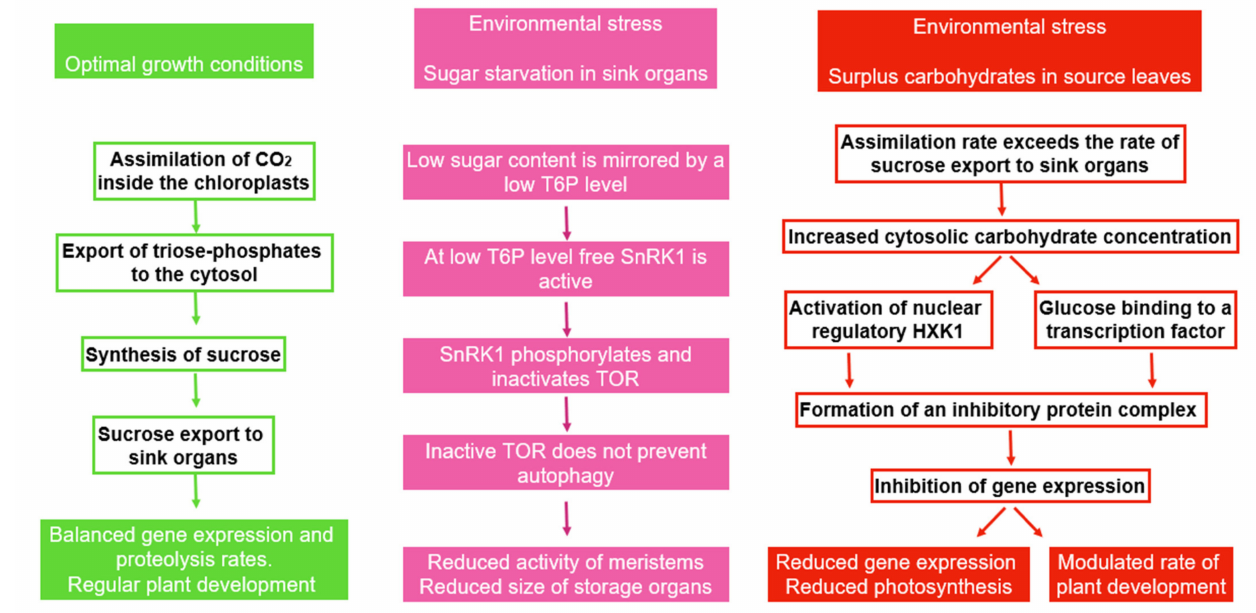
Figure 8. The three columns in this figure indicate how stress may affect the physiological equilibrium in plants. In the left column, the sucrose supply of sink tissues under optimal growth conditions is indicated. The columns in the middle and on the right, respectively, show the modified situation in sink tissues and source leaves under